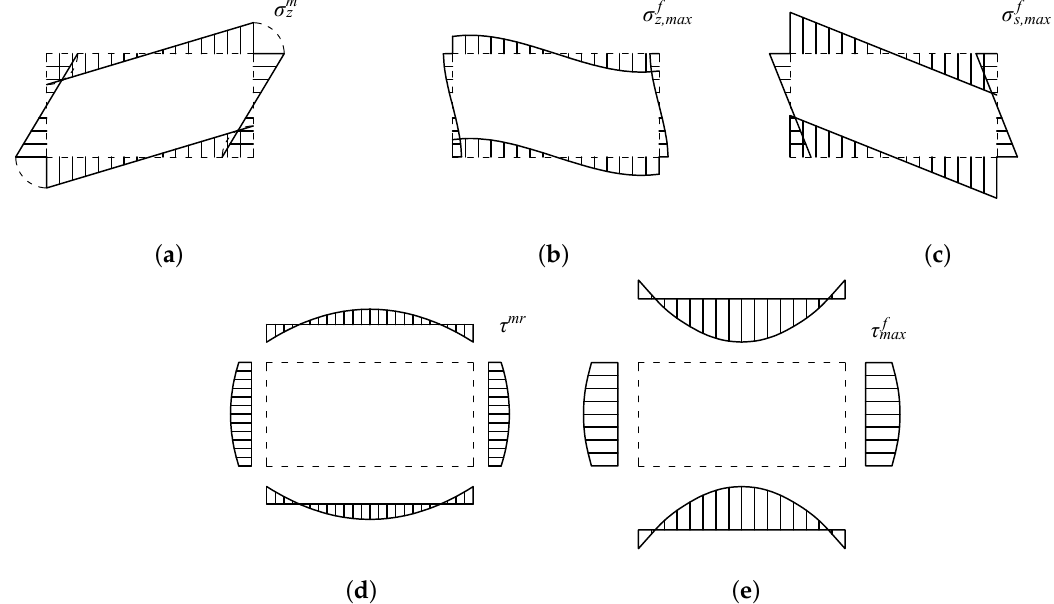
Figure 8. Stresses in the distortional mode: ( a ) membrane longitudinal normal stress, ( b ) flexural longitudinal normal stress, ( c ) flexural transverse normal stress, ( d ) membrane reactive tangential stresses, and ( e ) flexural tangential stress. ( b , c , e ) the index max denotes evaluation at the top/bottom face of the plates (i.e., at y i = ± t i 2